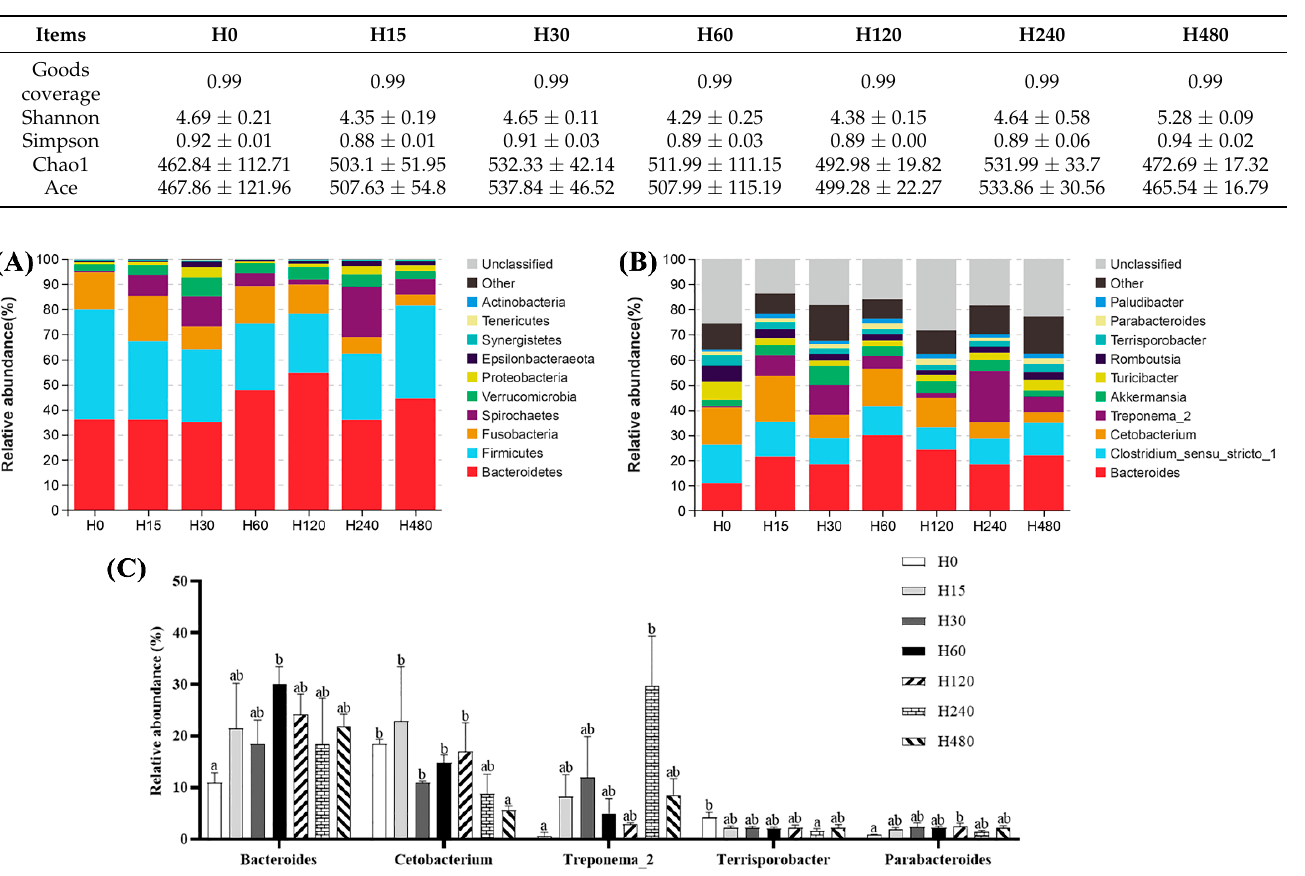
Table 7. Effect of dietary histamine on microbiota α -diversity of striped catfish.